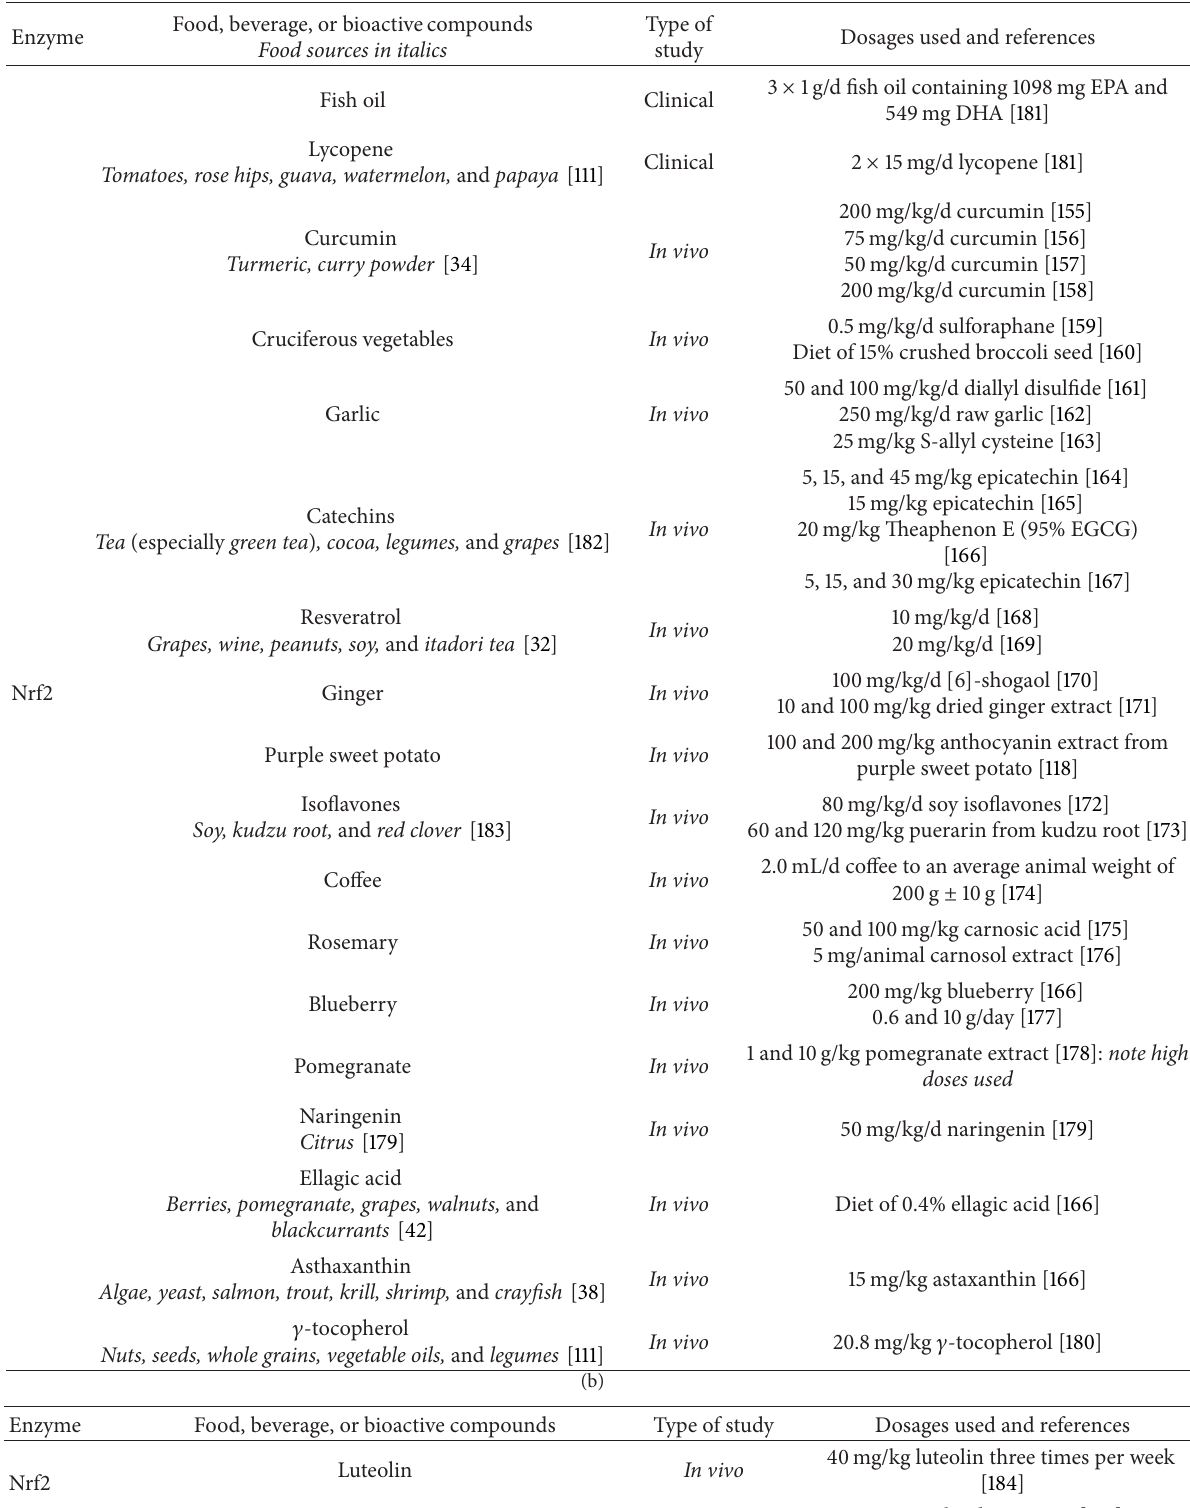
Table 10: (a) In vivo example nutrient inducers of the Nrf2 pathway. (b) In vivo example nutrient inhibitors of the Nrf2 pathway.